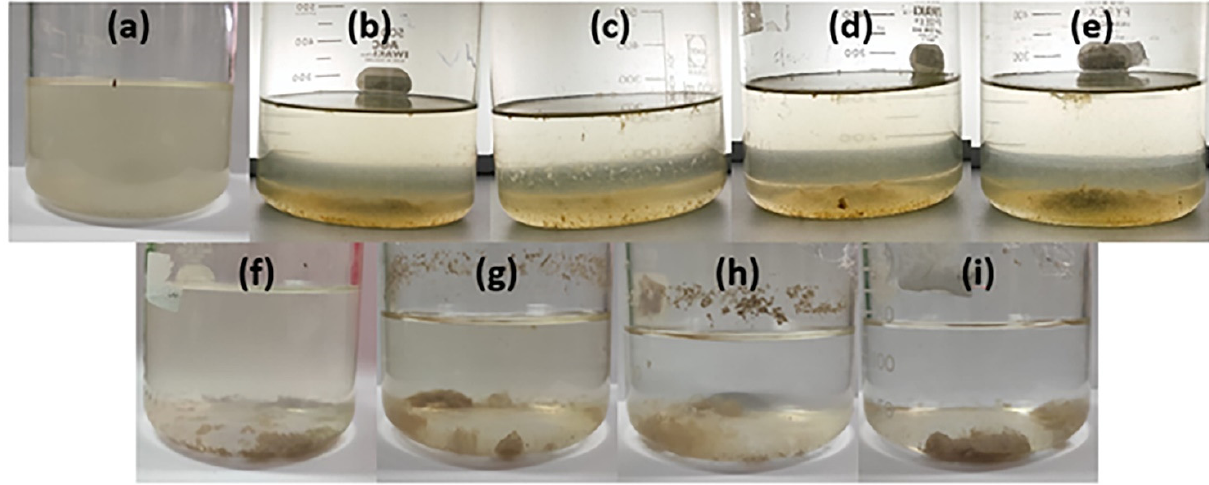
Figure 5. Physical appearance of water samples ( a ) before and after treatment with ( b ) pristine chitosan, ( c ) NCS1, ( d ) NCS2, ( e ) NCS3, ( f ) NCS4, ( g ) NCS5, ( h ) NCS6 and ( i ) NCS7 chitosan nanoparticles.